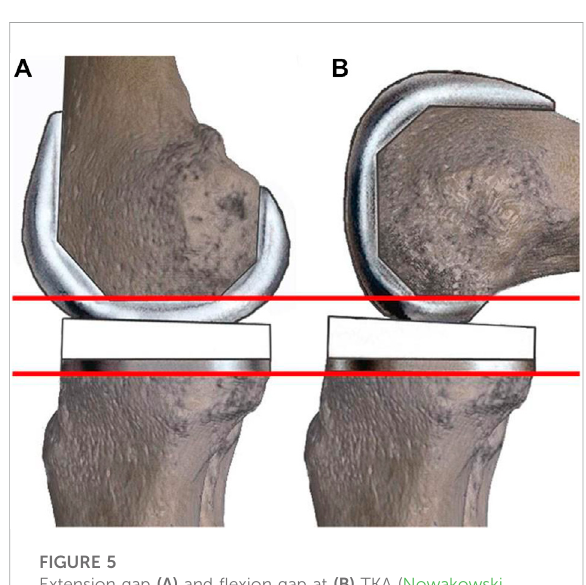
FIGURE 5 Extension gap (A) and fl exion gap at (B) TKA (Nowakowski et al., 2014).